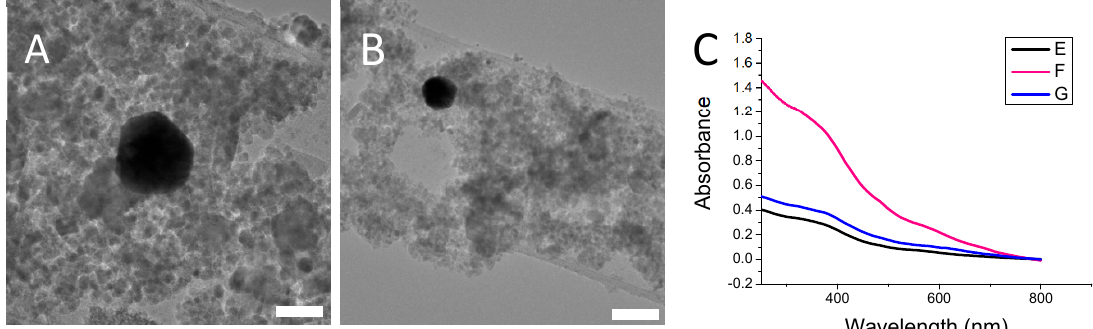
Figure 6. ( A ) TEM images of PSS-Stabilised Fe 3 O 4 and acetic acid stabilized Au NPs. Scale bar = 50 nm; ( B ) TEM image of PSS-Stabilised Fe 3 O 4 and acetic acid stabilized Au NPs. Scale bar = 100 nm; ( C ) UV-Vis spectra for each acetic acid stabilized Au and PSS-stabilised Fe 3 O 4 nanocomposite after multiple magnetic separations. E, F and G refer to the three samples of acetic acid stabilized gold nanoparticles that were prepared with varying amounts of gold (III) chloride and acetic acid solutions. These can be found in Table 2. Amounts of gold (III) chloride solution (x ( μ L)) and acetic acid (y ( μ L)) used to synthesise acetic acid stabilized gold nanoparticles. x ( μ L) y( μ L) x ( μ L)